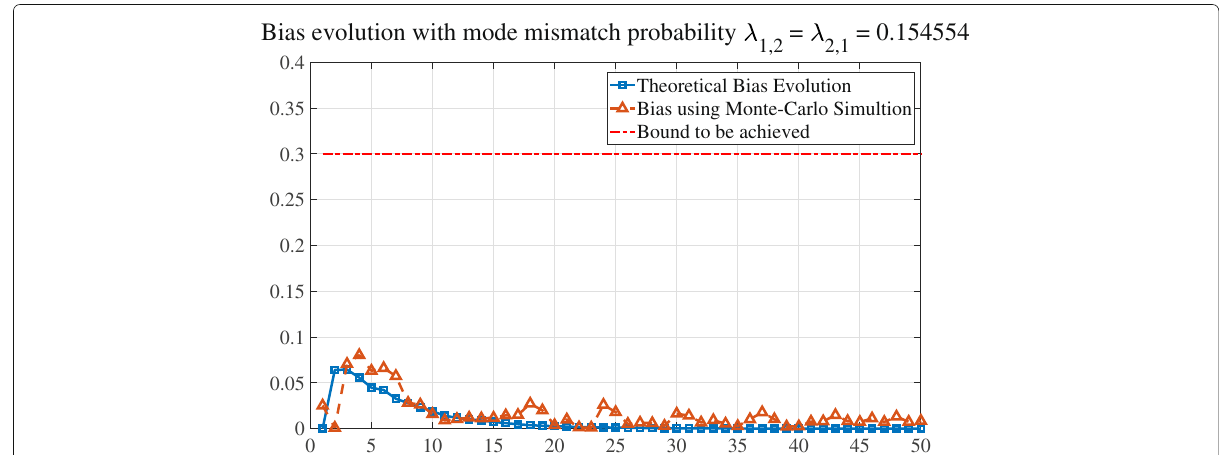
Fig. 6 To achieve an upper bound of bias B = 0.3, the bias evolution with probability of mode mismatch as λ 1,2 = λ 2,1 = 0.154554